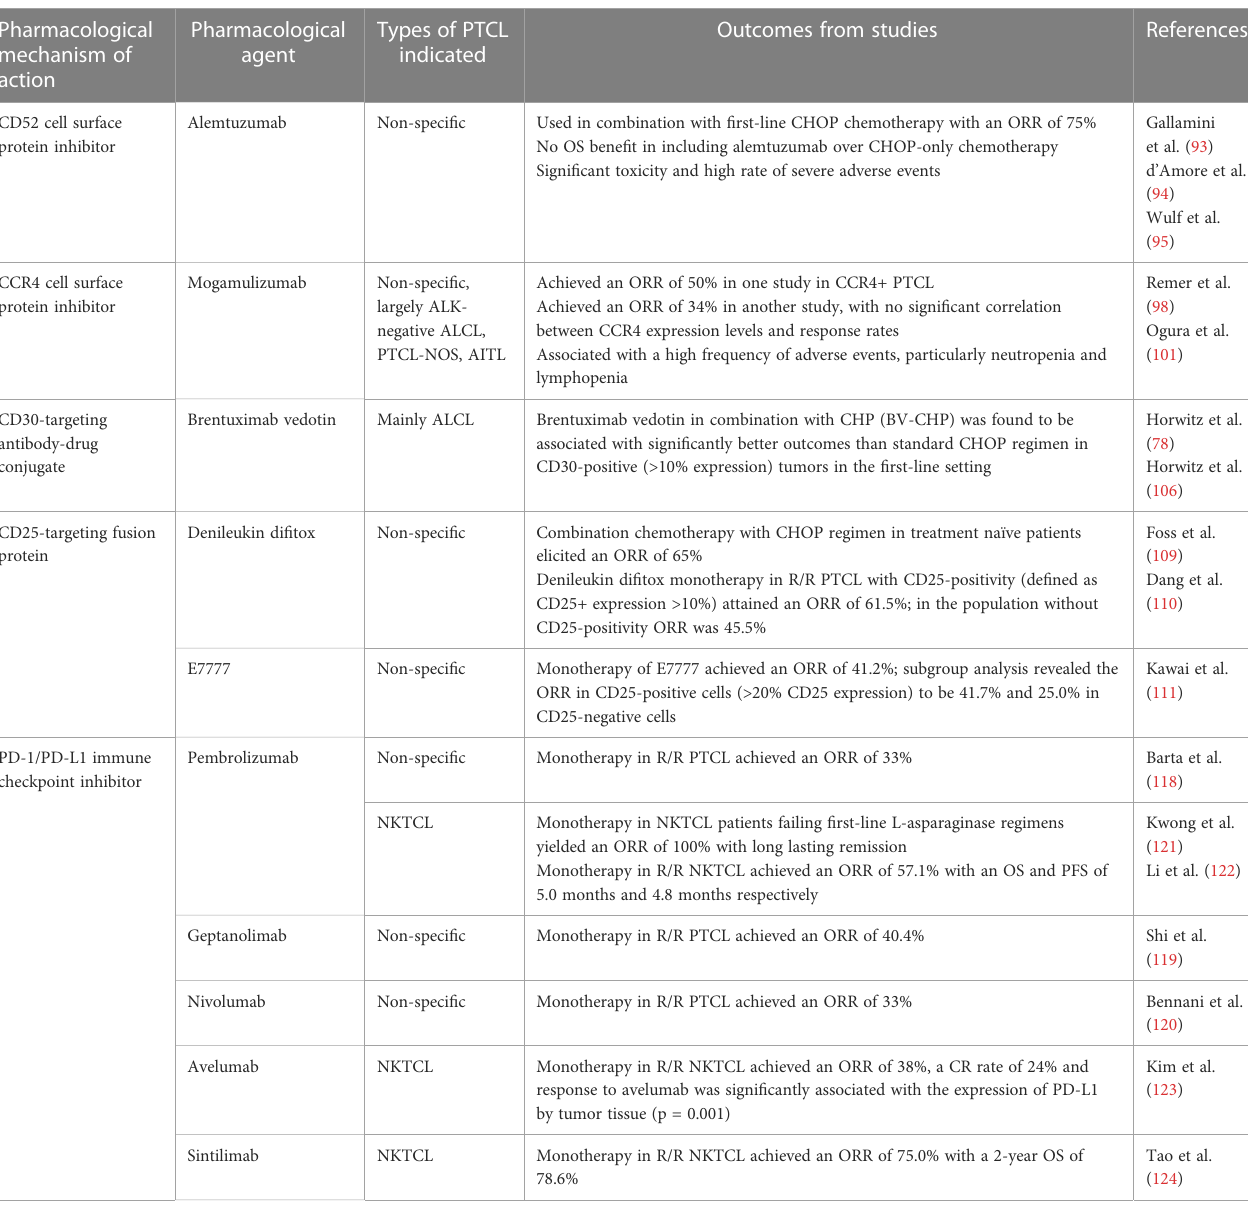
TABLE 4 Summary of novel therapeutics and data on current ef fi